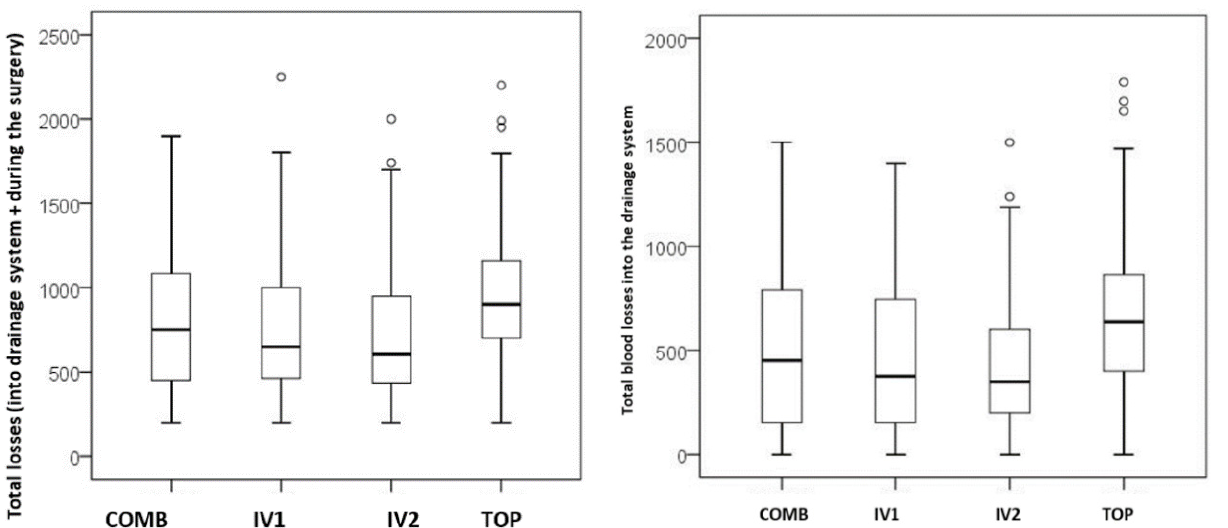
Fig. 2. Graphical representation of the range of blood loss dur- ing surgery and postoperative period into drainage systems in individual groups.